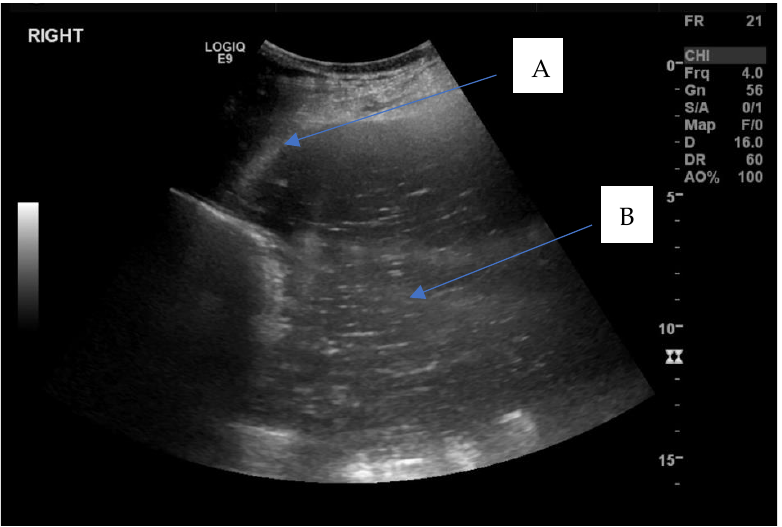
Figure 1. Transabdominal ultrasound showing a distended uterus filled with hyperechoic fluid within uterine lumen. A—uterine wall, B—large volume (>10 cm depth) of mucopurulent intrauterine fluid. Vaginoscopic examination using a vaginal speculum (KRUUSE Vaginal Speculum 35 cm, Jørgen Kruuse A/S, Langeskov, Denmark) and palpation per vaginum subsequently revealed a tight cervix that was unable to be manually dilated for evacuation of the